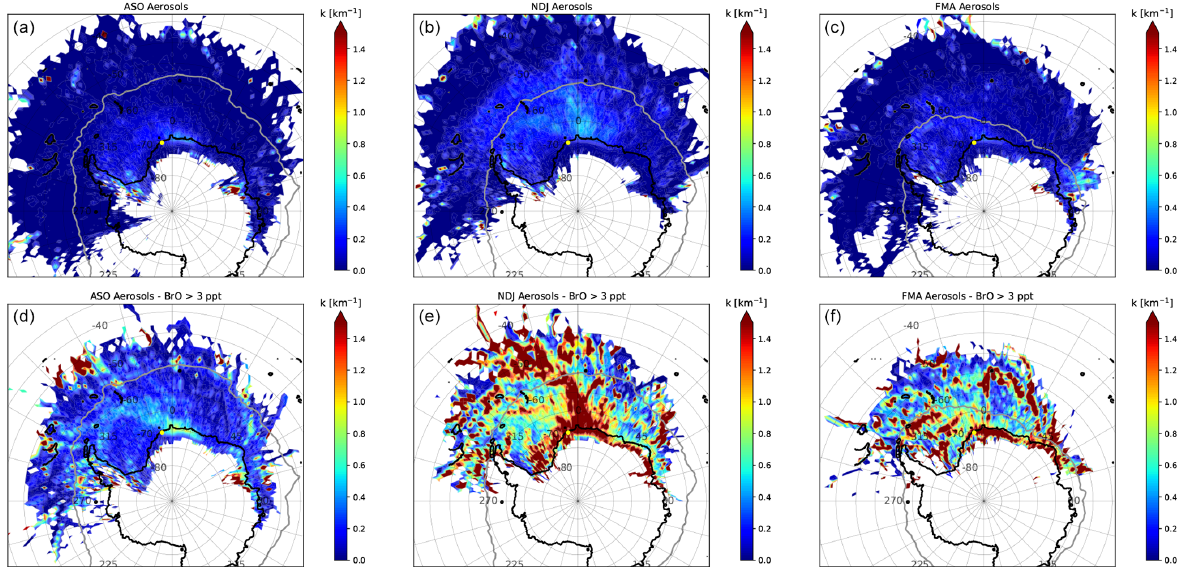
Figure 14. Source–receptor distribution of mean aerosol extinction at NM for all data (a–c) and for only BrO > 3ppt (d–f) during ASO (a, d) , NDJ (b, e) , and FMA (c, f) . Note the different colour scale compared to Figs. 12 and 13.